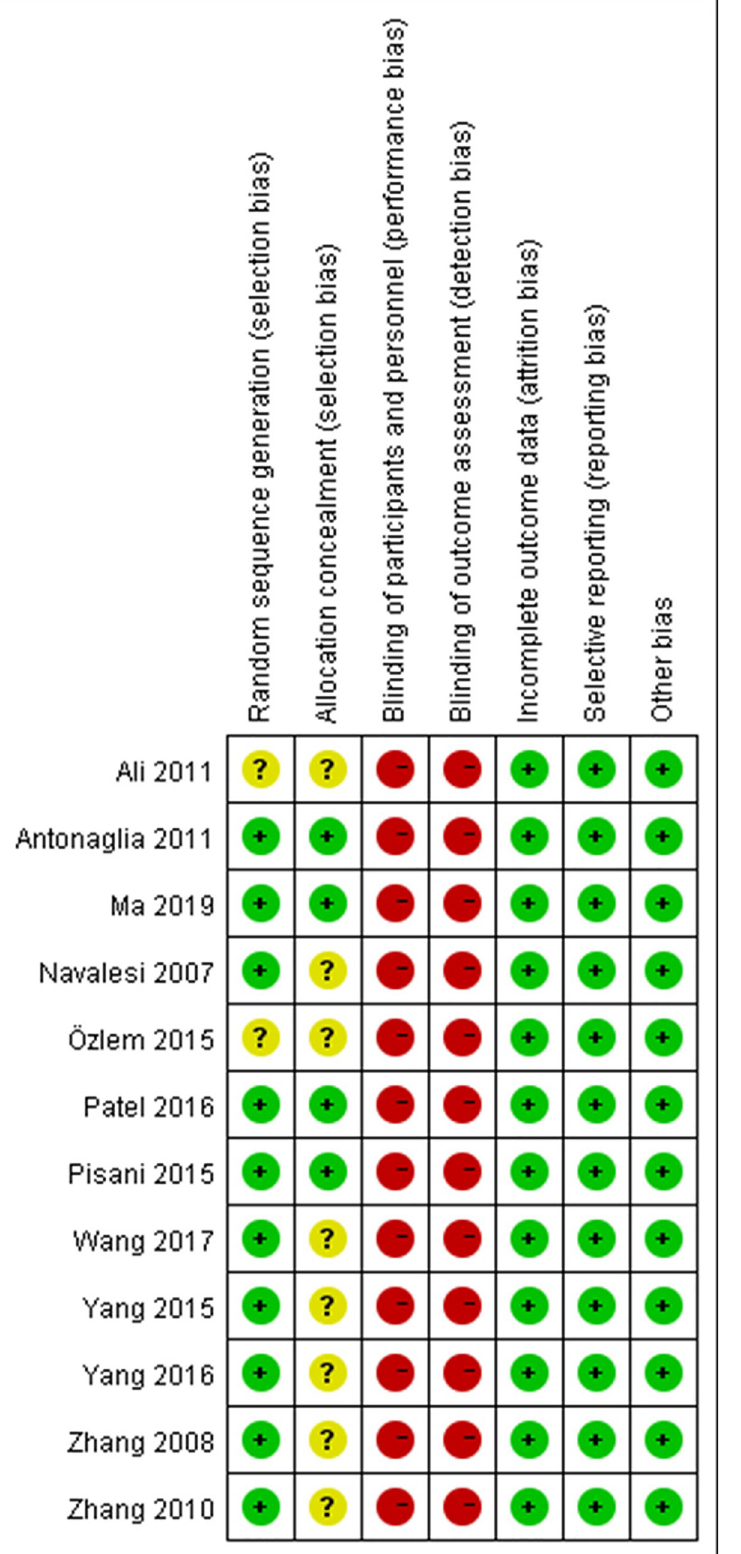
Fig 2. Risk of bias